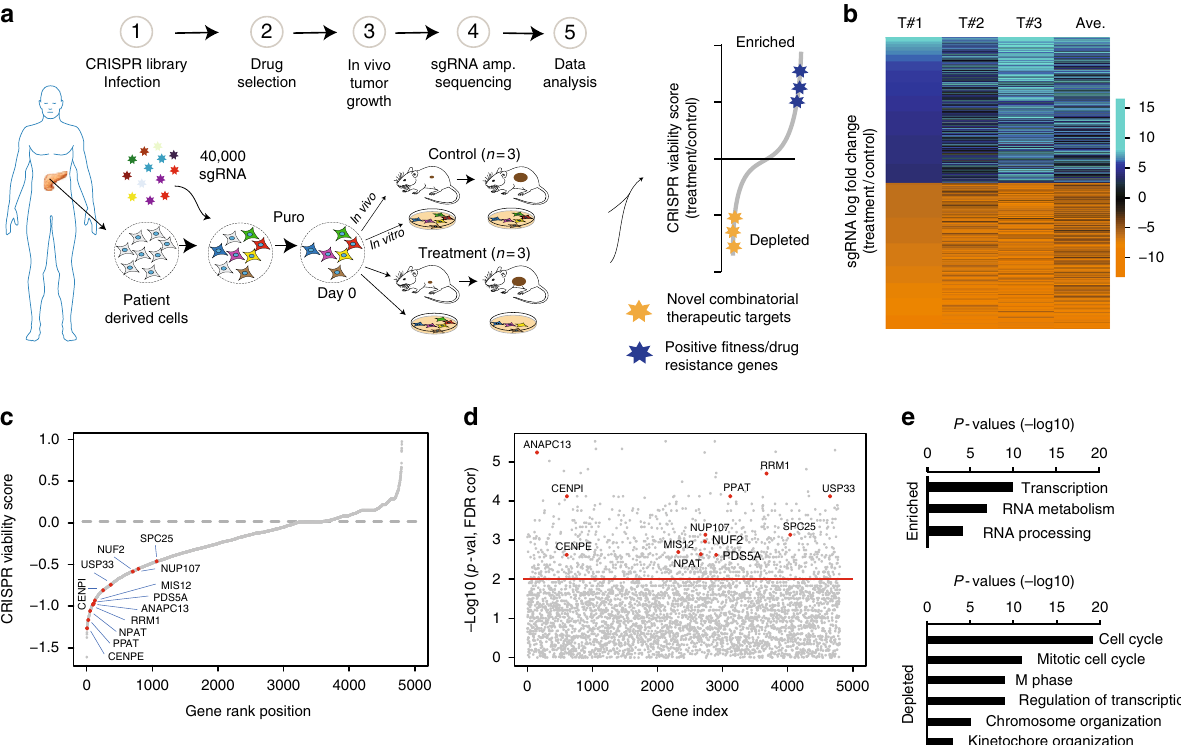
Fig. 1 In vivo CRISPR screening identi fi es novel drug targets. a The experimental outline of in vivo genetic knockout screening in PDX model of PDAC. b The heat map represents log-fold change of the top 2000 enriched and depleted sgRNAs in three separate trametinib-treated tumors relative to the mean of control-treated tumors. c Plot showing the distribution of normalized CRISPR viability scores (treatment vs control) for genes targeted by the sgRNA library. Shown are all targeted genes. Red dots indicate signi fi cantly depleted kinetochore genes as assessed by one-sided Kolmogorov – Smirnov test. d The plot showing the signi fi cance score (treatment vs control) of all gene depletion (minus log-transformed p values) as determined by Kolmogorov – Smirnov test. Kinetochore genes are labeled with red dots. e Gene ontology (GO) analysis depicts the signi fi cantly enriched GO terms for the top enriched and depleted gene sets ( n = 100) from in vivo screening. Log-transformed p values are represented by bar